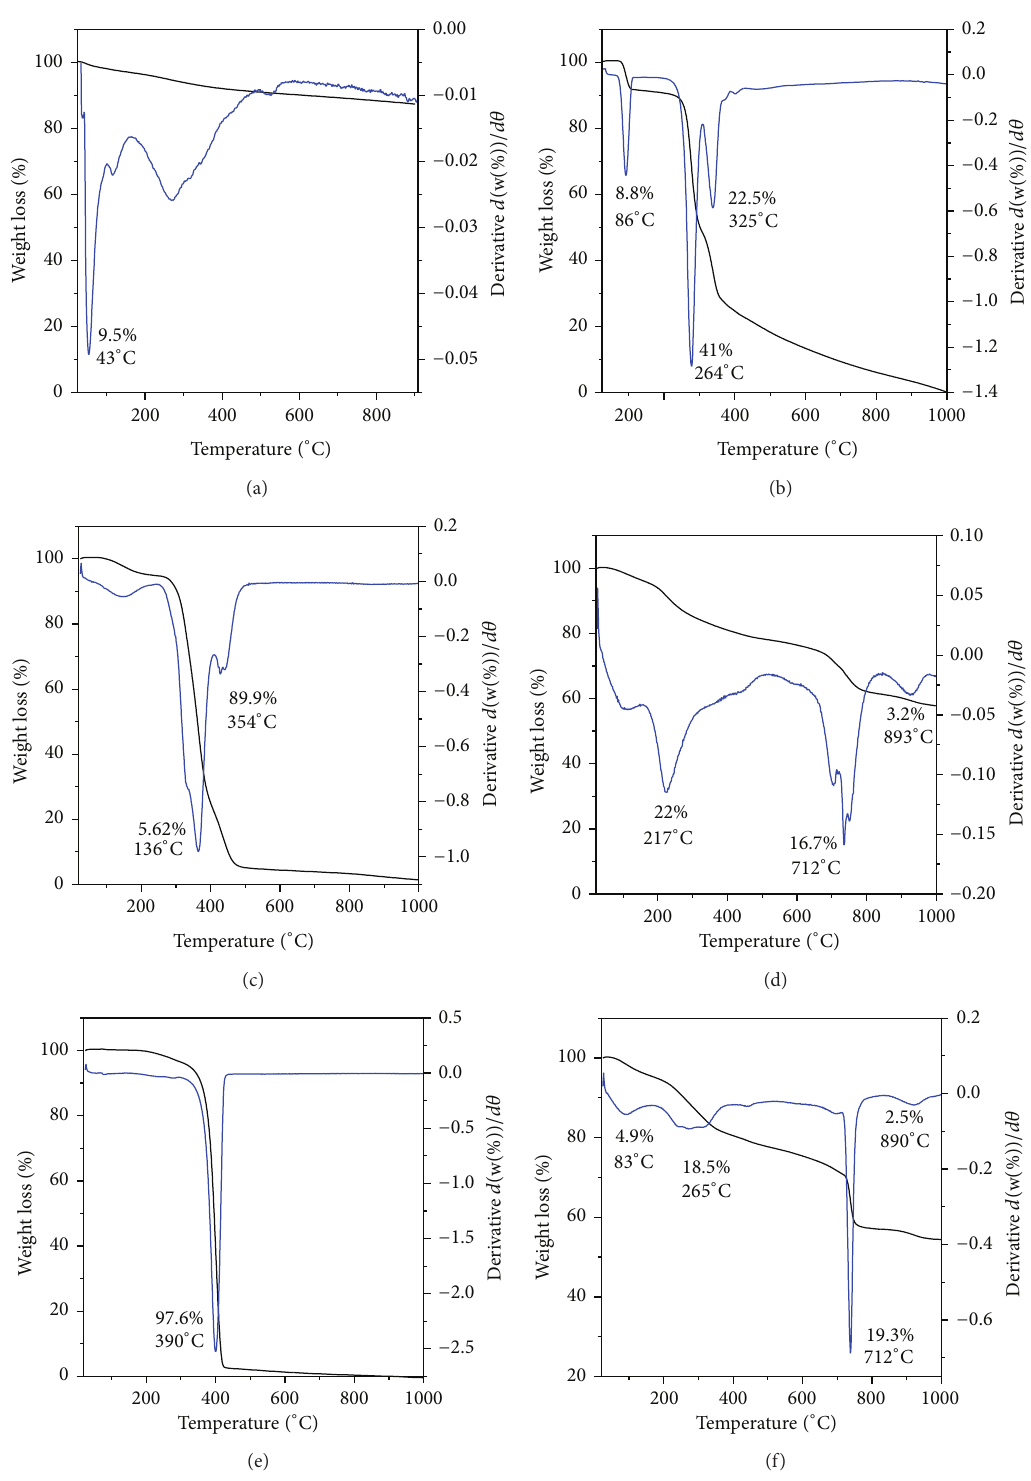
Figure 3: TGA/DTG of (a) FNPs, (b) GA, (c) PVA, (d) FPVAG nanocomposite, (e) pure PEG, and (f) FPEGG nanocomposite. (300), it can be found that the maghemite (Fe 2 O 3 , 𝛾 -Fe 2 O 3 ) does not exist in the as-synthesized iron oxide and